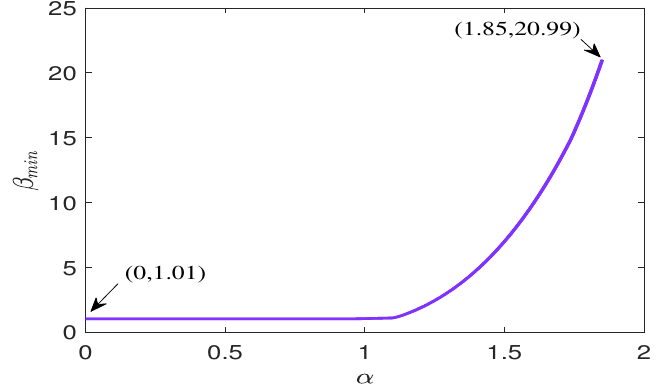
Figure 3. Curve of ϕ vs. ψ min for SFC case.